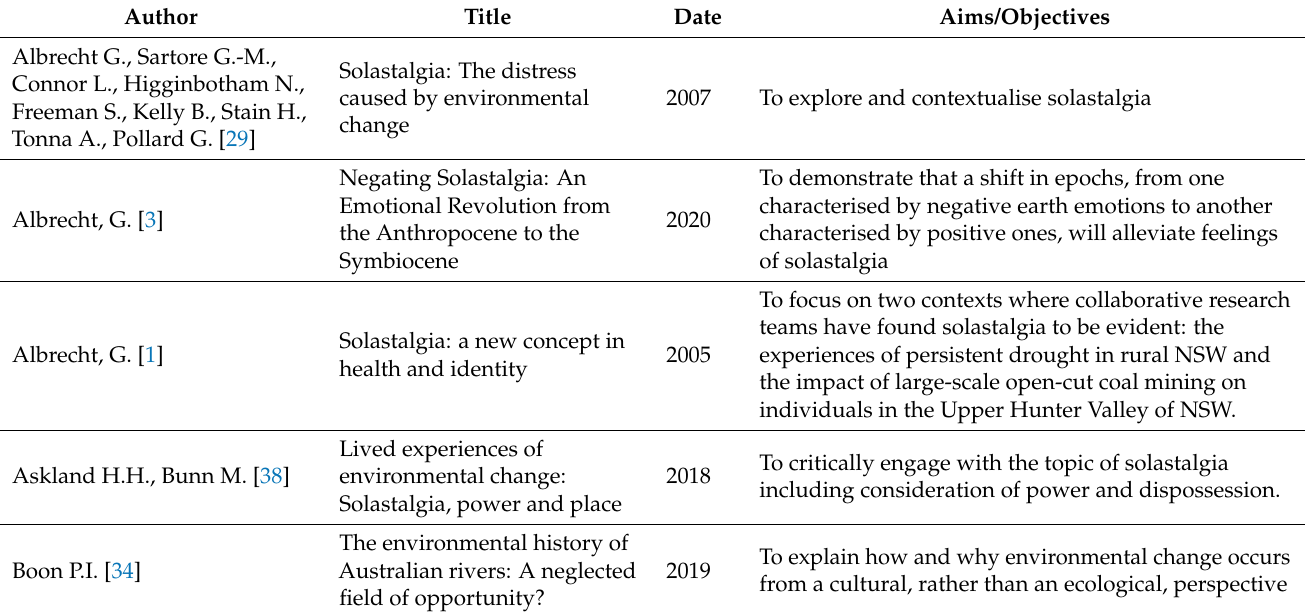
Table A1. Table summarising papers included in this review (author, title, date,